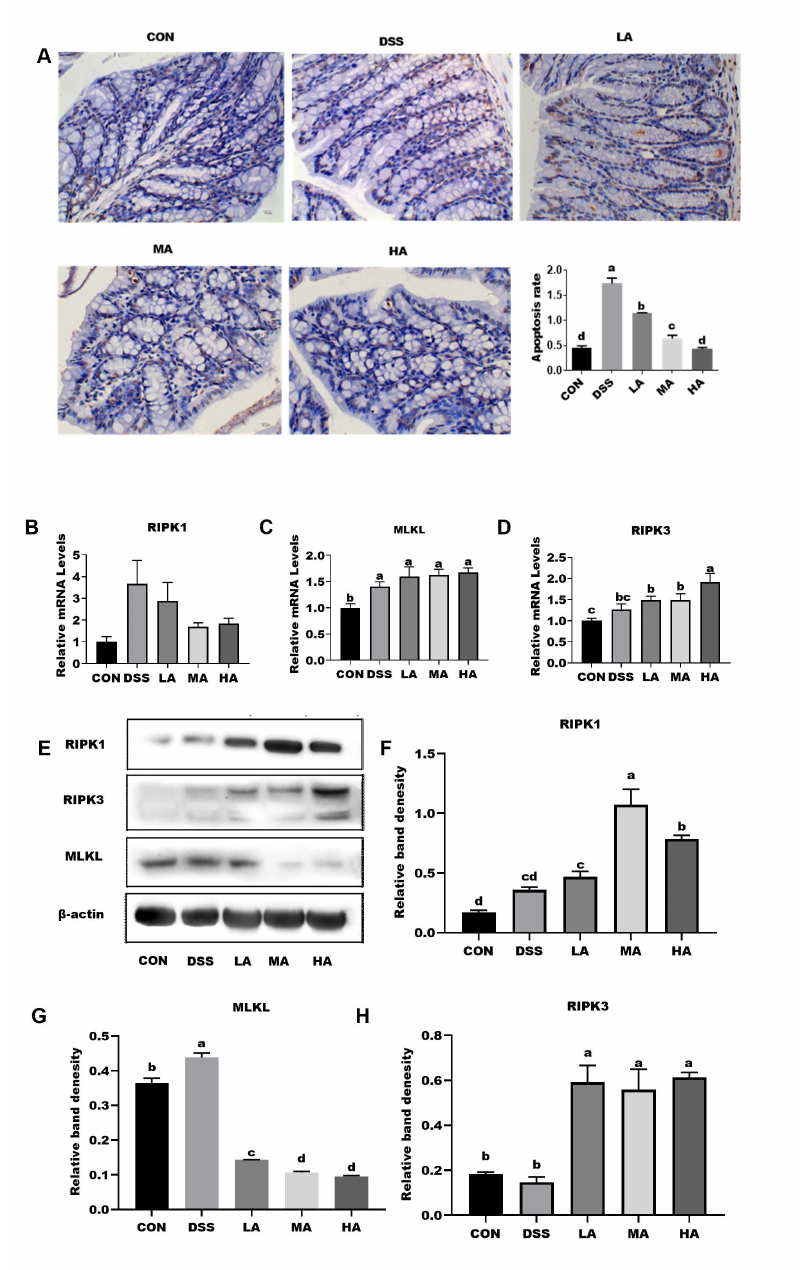
Figure 4. The effects of aspartate on cell apoptosis and the expression of RIPK pathways in the colon of DSS-induced mice. ( A ) The TUNEL assay shows colonic apoptosis section and rate of apoptosis; blue, living cells; brown, dead cells. ( B ) The mRNA expression level of colonic RIPK1. ( C ) The mRNA expression level of colonic MLKL. ( D ) The mRNA expression level of colonic RIPK3. ( E ) The protein band of RIPK1, MLKL, RIPK3, and β -actin. ( F ) The relative protein expression of RIPK1. ( G ) The relative protein expression of MLKL. ( H ) The relative protein expression of RIPK3. Values are expressed as the mean ± SEM, n = 6. a, b, c, d Mean values with different small letter superscripts mean a significant difference ( p <